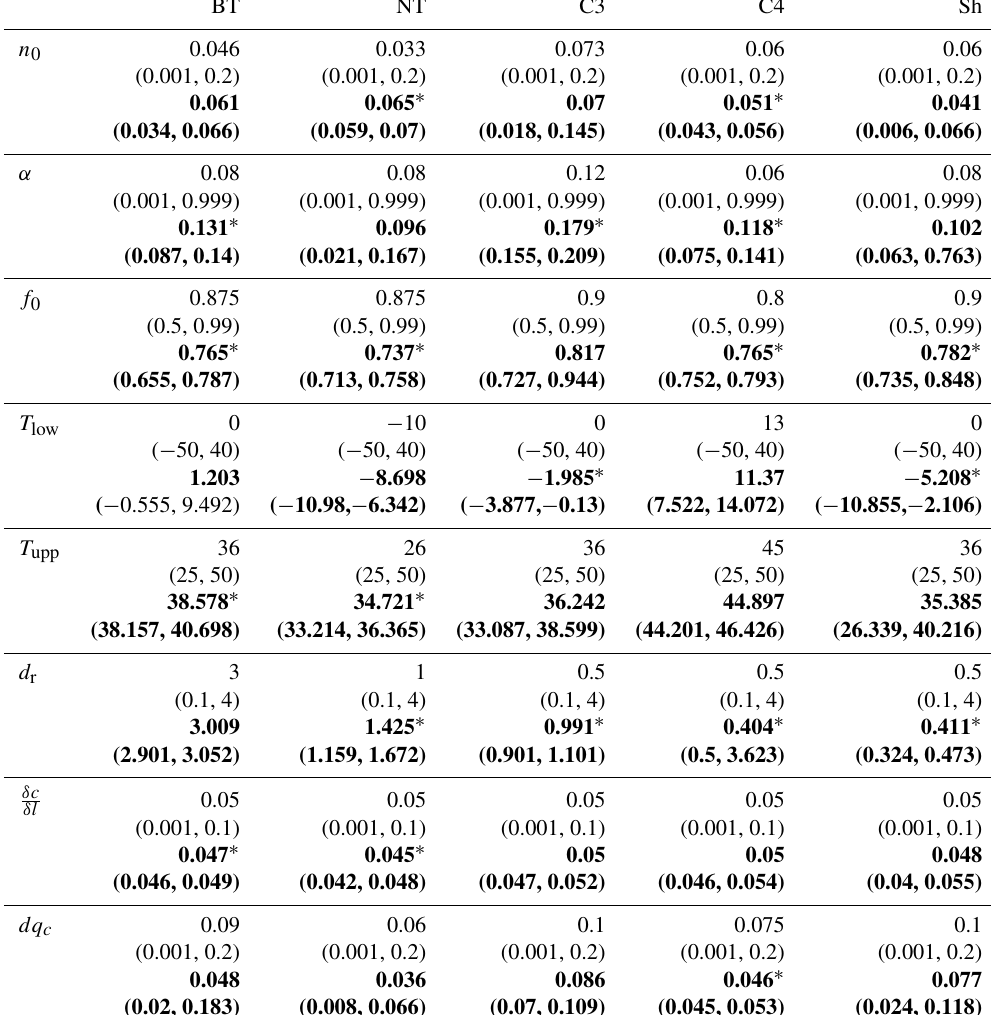
Table B1. PFT-specific JULES parameters optimised in this study (Table 1). The prior values and ranges for each PFT are given. Below in bold are the optimised values and posterior uncertainty ranges given as an 80% confidence interval (in parentheses). Optimised values for which the prior values lie outside the posterior range are highlighted by (*). A graphical version of this table is shown in Fig. 3. BT